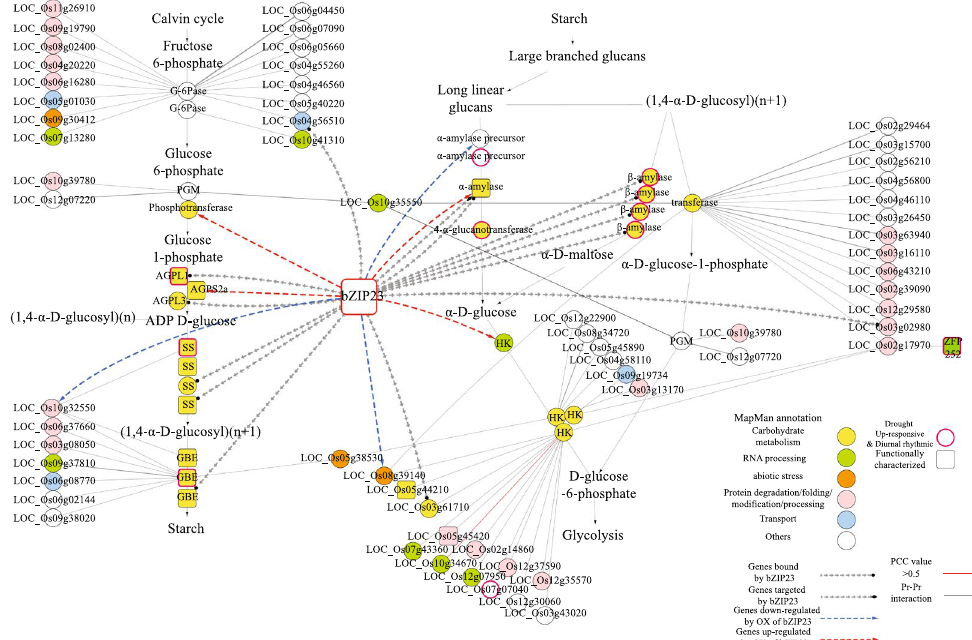
Figure 7. Analysis of functional gene network associated with pathways for starch biosynthesis and starch degradation. We used RiceCyc, Rice Interaction Viewer, and Cytoscape program to develop network, based on information derived from MapMan analysis. Nodes with bold-red borders, genes that are both diurnally rhythmic and up-regulated by drought; rounded rectangles, genes for which functions were reported previously. Colored nodes (circles) represent functional classification information from MapMan analysis (see Fig. 4), with color of edge indicating differential Pearson’s correlation coefficient (PCC) values that were calculated using anatomical microarray data from ROAD, and which ranged > 0.5 (red). Thickness of edge was determined based on Interlog confidence value from Rice Interaction Viewer, with thicker edges indicating higher confidence. Dotted arrows with circle heads show genes encoding proteins bound by OsbZIP23; dotted lines with triangle heads, genes targeted by OsbZIP23. Blue-dotted lines, genes regulated negatively in overexpression of OsbZIP23; red-dotted lines, genes regulated positively in overexpression of OsbZIP23. Color indicates assigned function: yellow, carbohydrate metabolism; green, RNA processing; orange, abiotic-stress response; pink, protein degradation/folding/modification/processing; blue, transport; and white, other